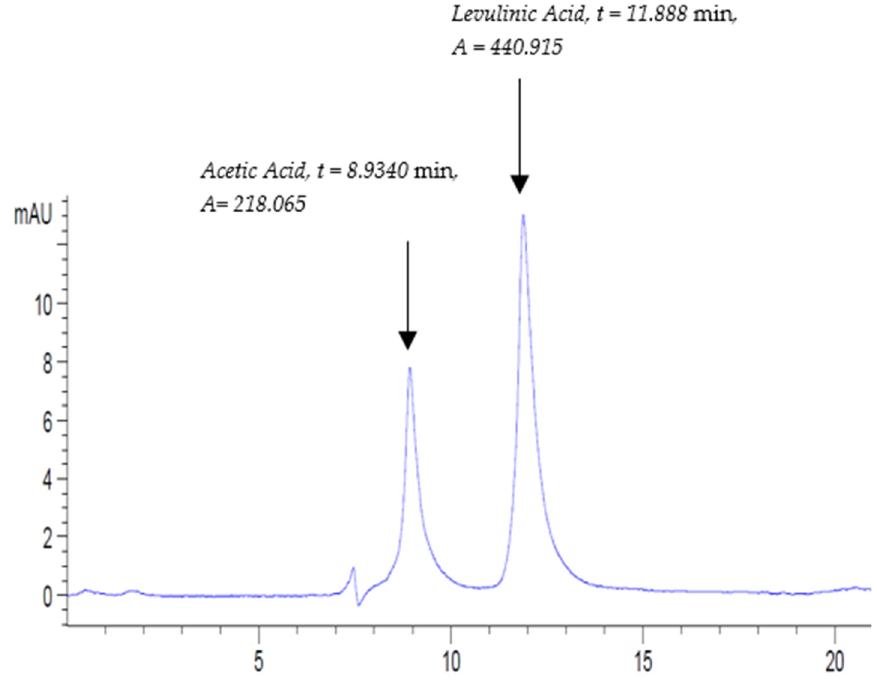
Figure 6. Apple cider vinegar (ACV(A)) chromatogram at UV 210 nm at the following conditions: